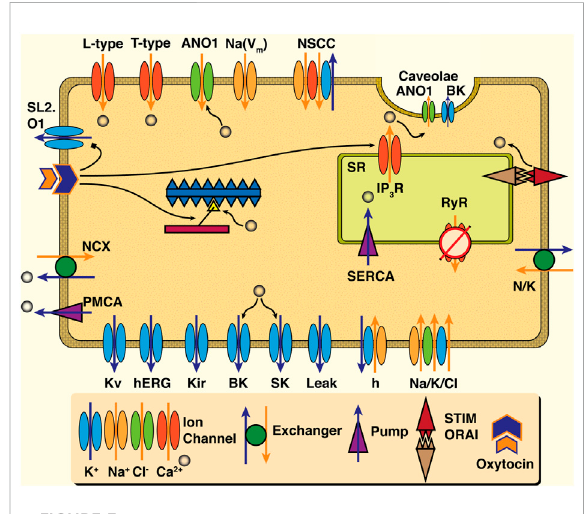
FIGURE 3 Schematic of cell dynamics relevant to uSMC. Ion channels ranging from the Ca 2+ L-type to the wide array of K + channels are present in the plasma membrane, and are colored by ion. Chloride channels such as the ANO1 appear not only on the plasma membrane but in the invaginations known as caveolae -- where Ca 2+ activated K + channels (the BK) reside in apposition with IP3R oftheSarcoplasmicReticulum(SR).Ca 2+ handlingmechanismsfor ejection to extracellular space (the NCX and PMCA) as well as uptake by the SR (SERCA) are present as well as the RyR with an apparentlyminorroleifatallinuSMC.Actionofhormonaloxytocin triggers variety of actions including release Ca 2+ from SR by way of IP3R, inhibition of the otherwise hyperpolarizing K+ channel the SL2. O1, and sensitization of the contraction machinery to Ca 2+ in fl uence. Ultimately an increase in extra-cellular Ca 2+ leads to activation of myosin light-chain kinase (MLCK) and initiates the cross bridge cycle which is shown in the center of the cell